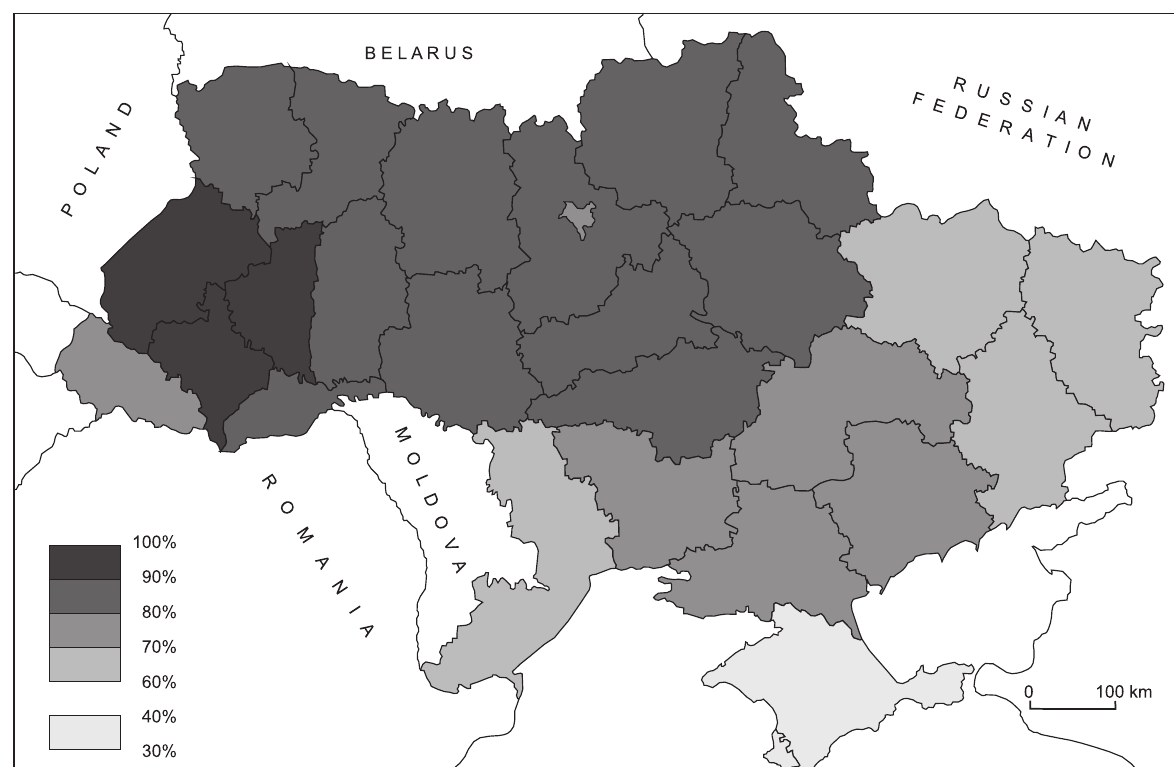
Fig. 2. Percentage of voters who supported independence during the referendum on 1 December 1991 (out of the total num - ber of voters) Source: http://www.archives.gov.ua/Sections/15r-V_Ref/index.php?11